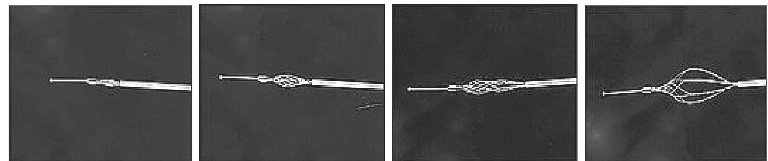
Figure 12. Sequence of opening of the shape memory basket. Taken from Ref. 34 (http:// smet.tomsk.ru/eng/prod.htm). Figure 13. Intra-aortic balloon pump. Taken from Ref. 16 with permission.